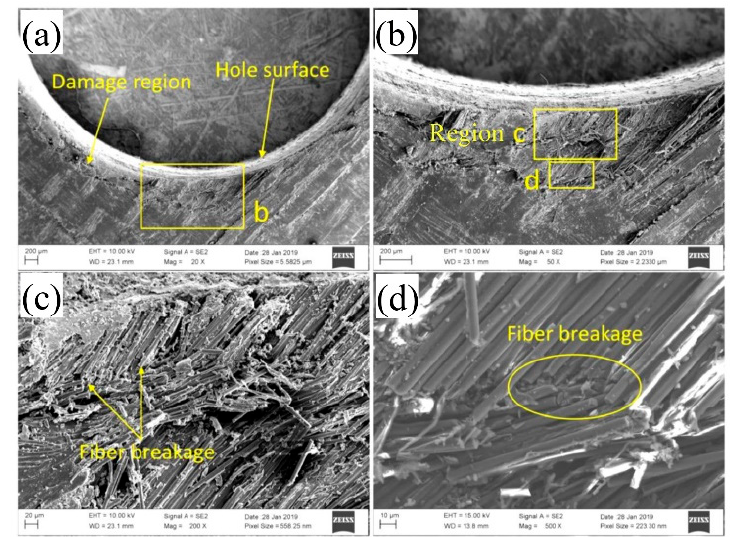
Figure 7. SEM scanning results of hole circumference at A [13].